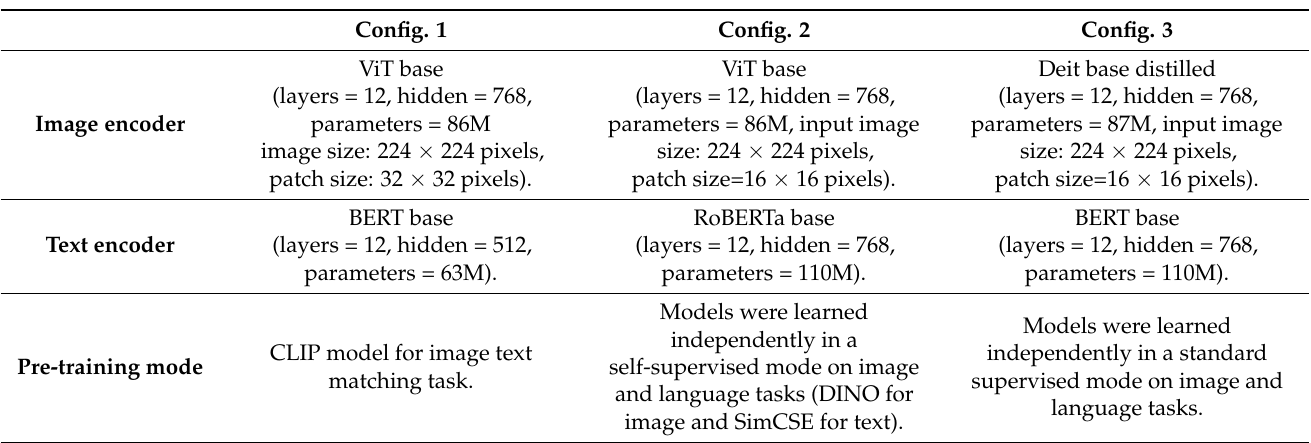
Table 1. Pre-trained configurations investigated for transferring knowledge to the cross-modal RS image–text retrieval task. Config. 1 Config. 2 Config.